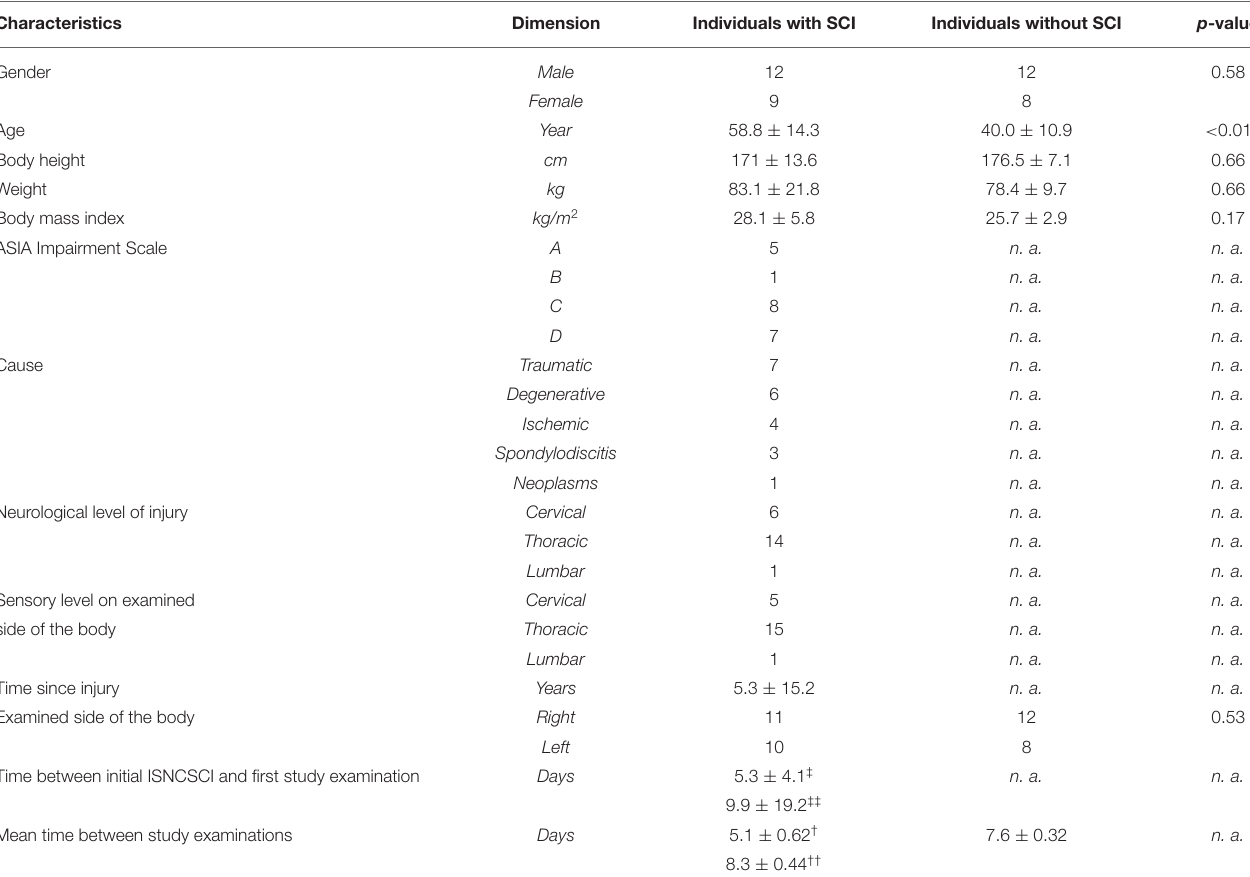
TABLE 1 | Demographics and sample characteristics.